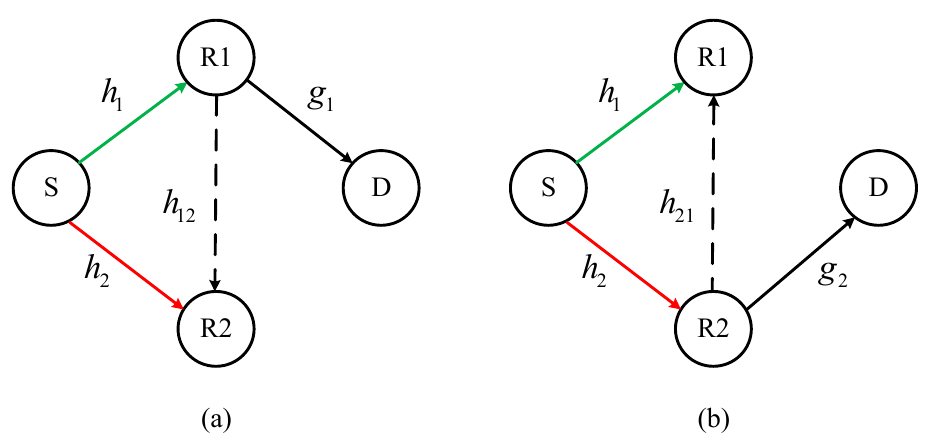
Figure 1. The system model. The green, red and black lines represent the first-hop and second-hop transmission, respectively. The green and dashed back lines represent the data transmission (DT) and energy harvesting (EH), respectively. ( a ) R 1 -DT and R 2 -EH; ( b ) R 2 -DT and R 1 -EH.